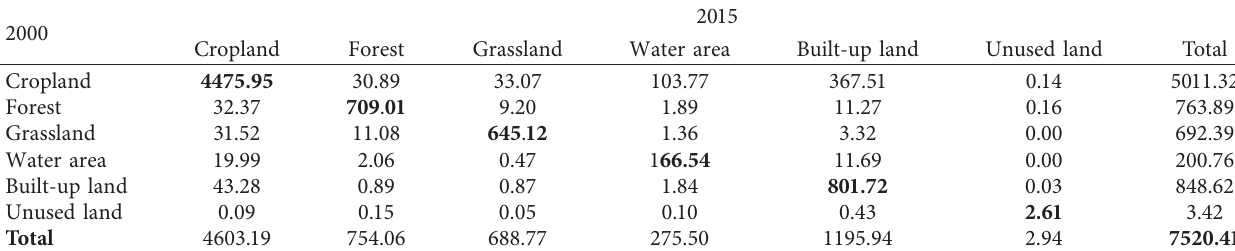
Table 1: Land transfer matrix between 2000 and 2015 (km 2